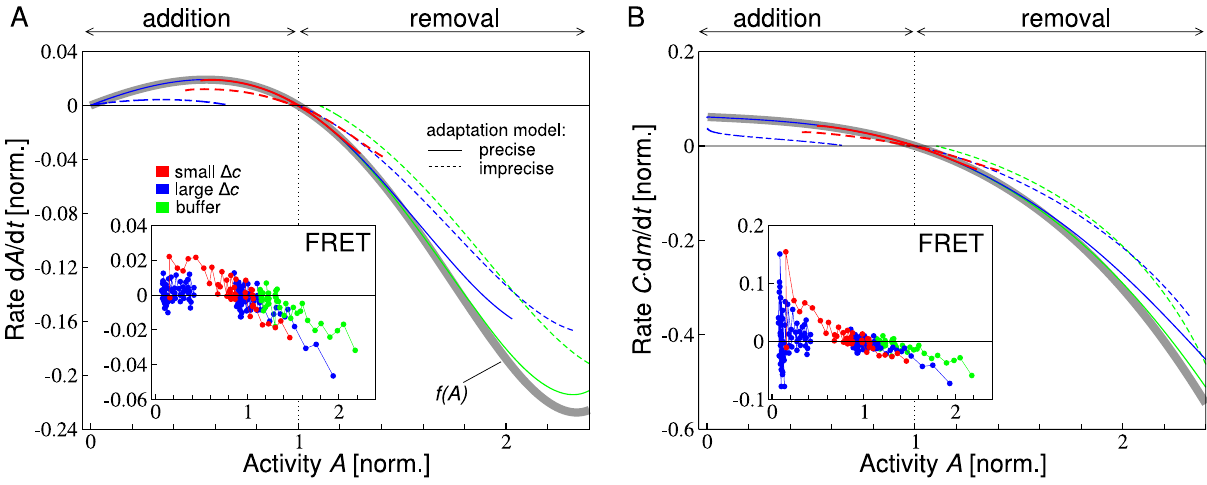
Figure 3. Adaptation dynamics as function of receptor activity for WT1 at ambient concentration c 0 ~~ 0 : 1mM for addition and subsequent removal of small (red lines and symbols) and large (blue lines and symbols) MeAsp concentration step changes, as well as removal of MeAsp back to zero ambient concentration (buffer; green lines and symbols). (A) Rate of change of receptor complex activity dA = dt as occurs during adaptation. Thick gray line is the analytical result from the dynamic MWC model, where activity change is purely from adaptation (methylation) dA = dt ~ dA = dm ð Þ dm = dt ð Þ ~ f A ð Þ . Colored lines show results from simulated time series for small ( D c ~ 0 : 03mM ) and large ( D c ~ 0 : 4mM ) concentration step changes in MeAsp concentration, with activity dynamics recorded starting 10 s after the onset of concentration step change. Precise (solid lines), as well as imprecise adaptation (dashed lines; m max ~ 4 : 1 and K ~ 0 : 5 ) are considered. (A Inset ) Rate of FRET activity change from experimental time-course data. Small ( D c ~ 0 : 03mM ) and large ( D c ~ 2mM ) concentration step changes. (B) Rate of change of the methylation level dm = dt corresponding to panel A (normalized by adapted activity A (cid:2) and C ~ N = 2 , where N is the receptor complex size). Effective rate of change of methylation level for all time courses is obtained by dA = dt ð Þ = A 1 { A ð Þ½ (cid:3) . (B Inset ) Effective rate of change of methylation level from experimental time-course data. FRET and receptor complex activities, as well as activity rate changes were normalized by adapted pre-stimulus activities at ambient concentrations before addition of MeAsp.